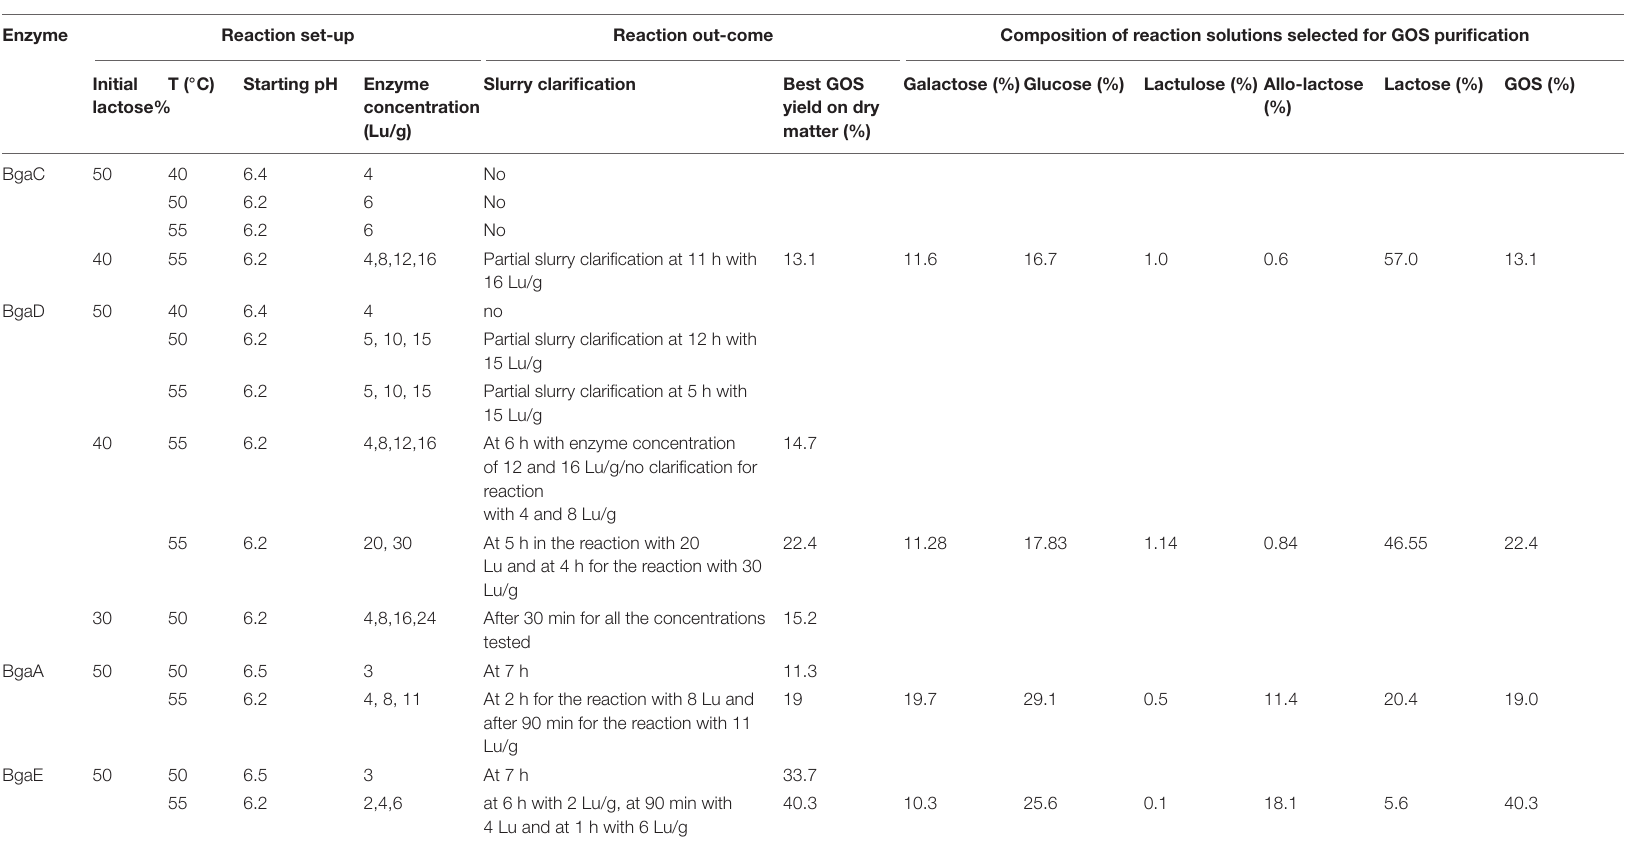
TABLE 1 | Galacto-oligosaccharides assay settings and GOS quantification related to GOS synthesis assay. Enzyme Reaction set-up Reaction out-come Composition of reaction solutions selected for GOS